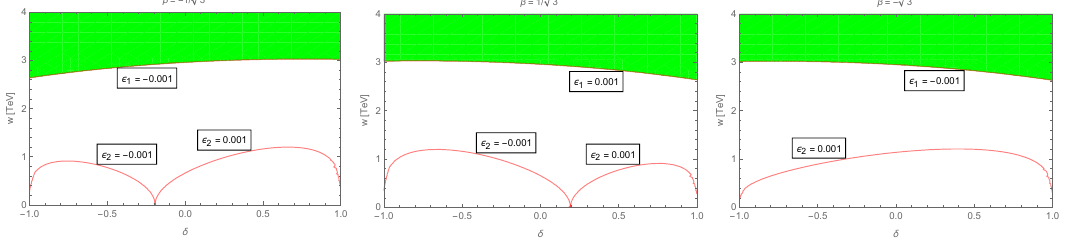
Figure 11 . The ( u, w ) regime that is bounded by the ρ parameter for β = −√ 3, b = t N = 0 . 5, and Λ = 2 w , where the panels, ordering from left to right, correspond to δ = and 0 . 9, respectively. In this case, the Landau pole, which is roundly w = 5 TeV, is imposed.